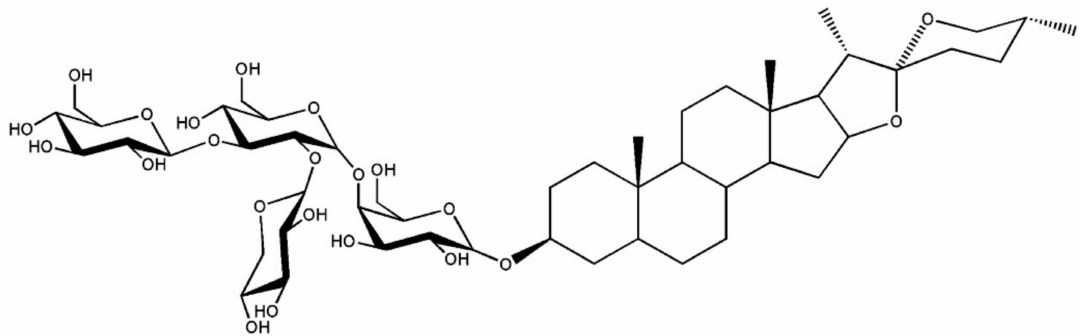
Figure 1. Saponin molecule extracted from sisal waste